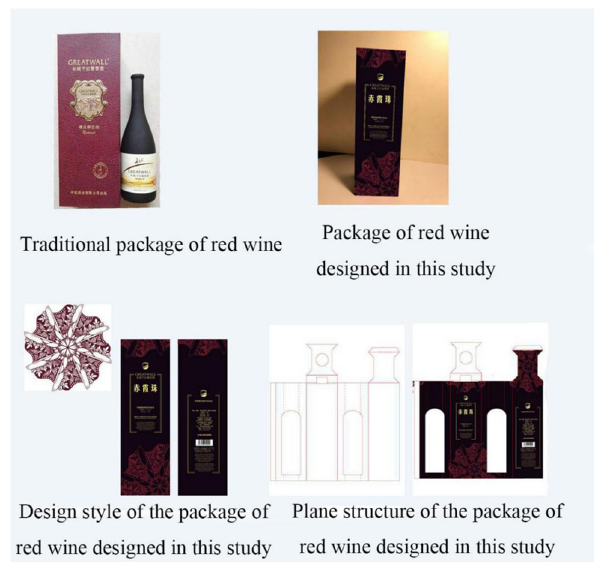
Figure 2: The schematic diagram of the red wine